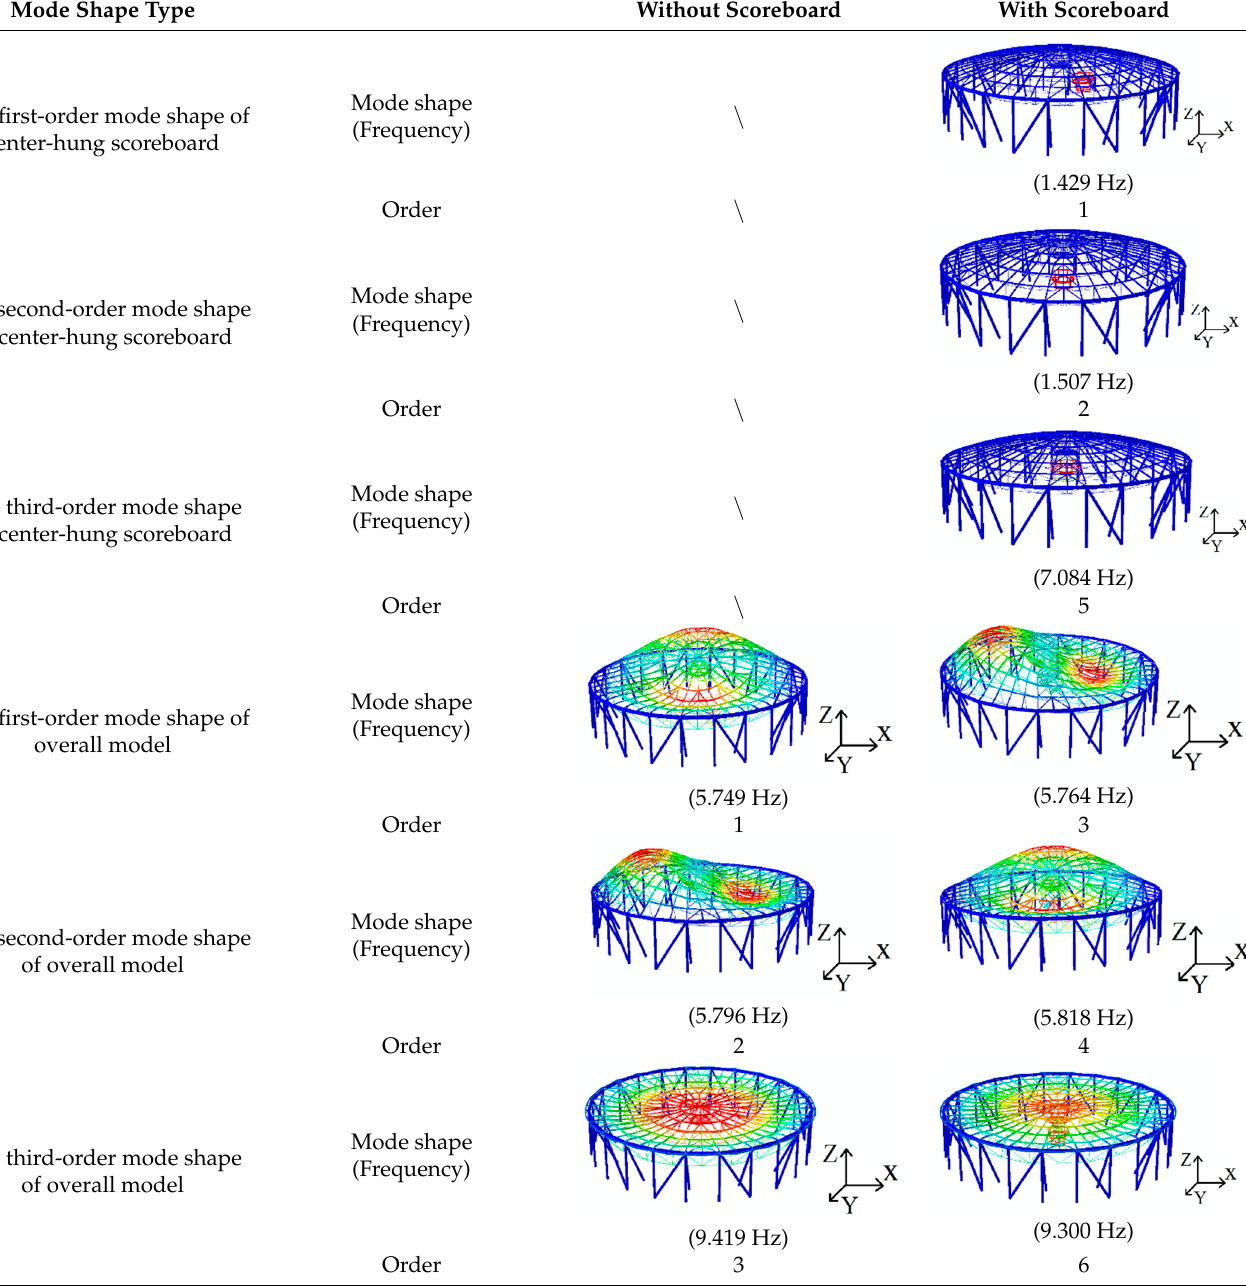
( c ) Figure 12. Seismic wave records: ( a ) TAFT wave acceleration time − history curve; ( b ) Hollister wave acceleration time − history curve; ( c ) Cholame wave acceleration time − history curve. Table 7. Loading case for shaking table test.